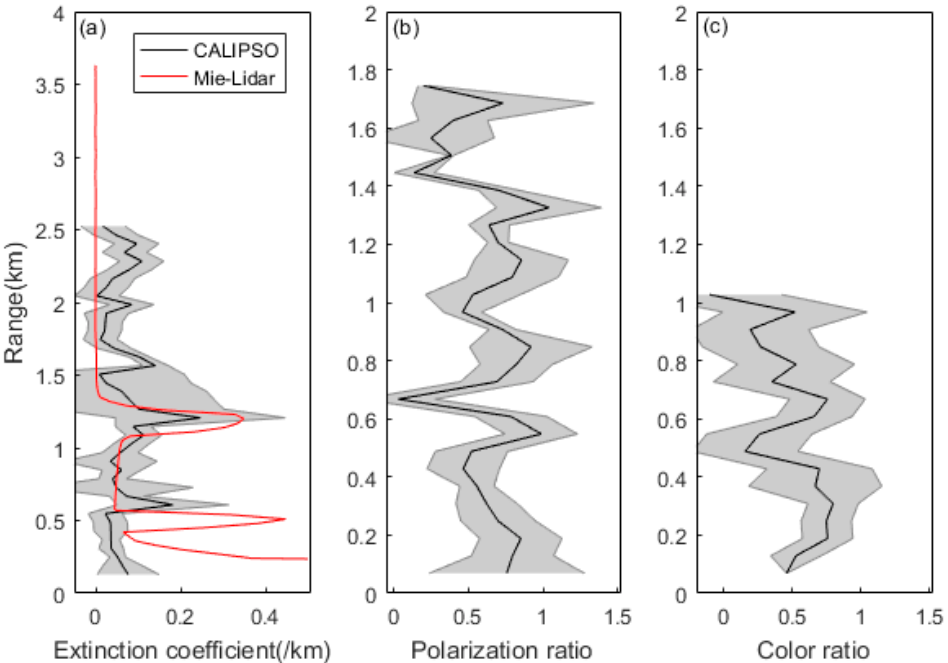
Figure 10. The vertical profile of aerosol characteristics, at 13:27 on June 29. ( a ) profile of extinction coefficient; ( b ) profile of polarization ratio; and ( c ) profile of color ratio.